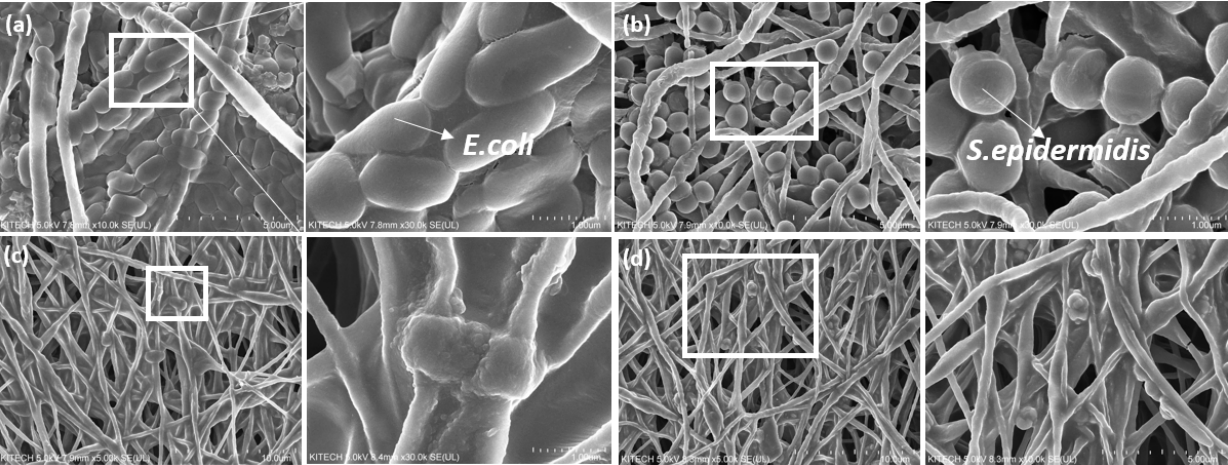
Figure 6. SEM images of bacterial adhesion phenomenon depending on antimicrobial activities: ( a ) neat PLA control against E. coli ; ( b ) neat PLA control against S. epidermidis ; ( c ) C10 against E. coli ; and ( d ) C10 against S. epidermidis after 24 h of incubation.